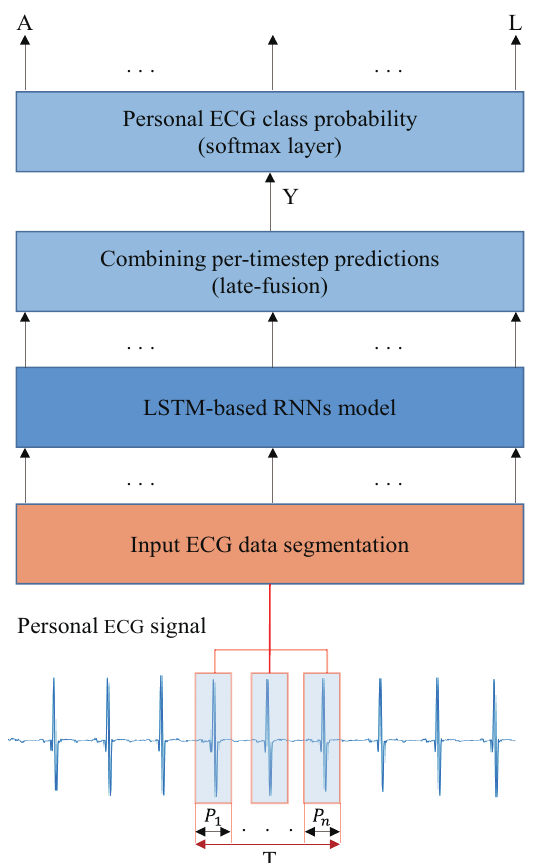
Figure 4. Proposed ECG identification architecture using LSTM-based RNN Model. The inputs are raw signals preprocessed from datasets, segmented into ECG components with a window size of T, and trained at the LSTM-based RNN model.